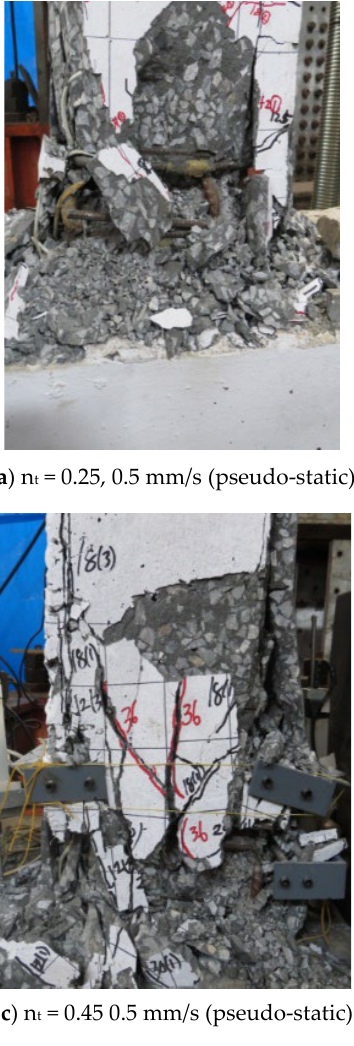
Figure 5. The cracks at the bottom of the column.